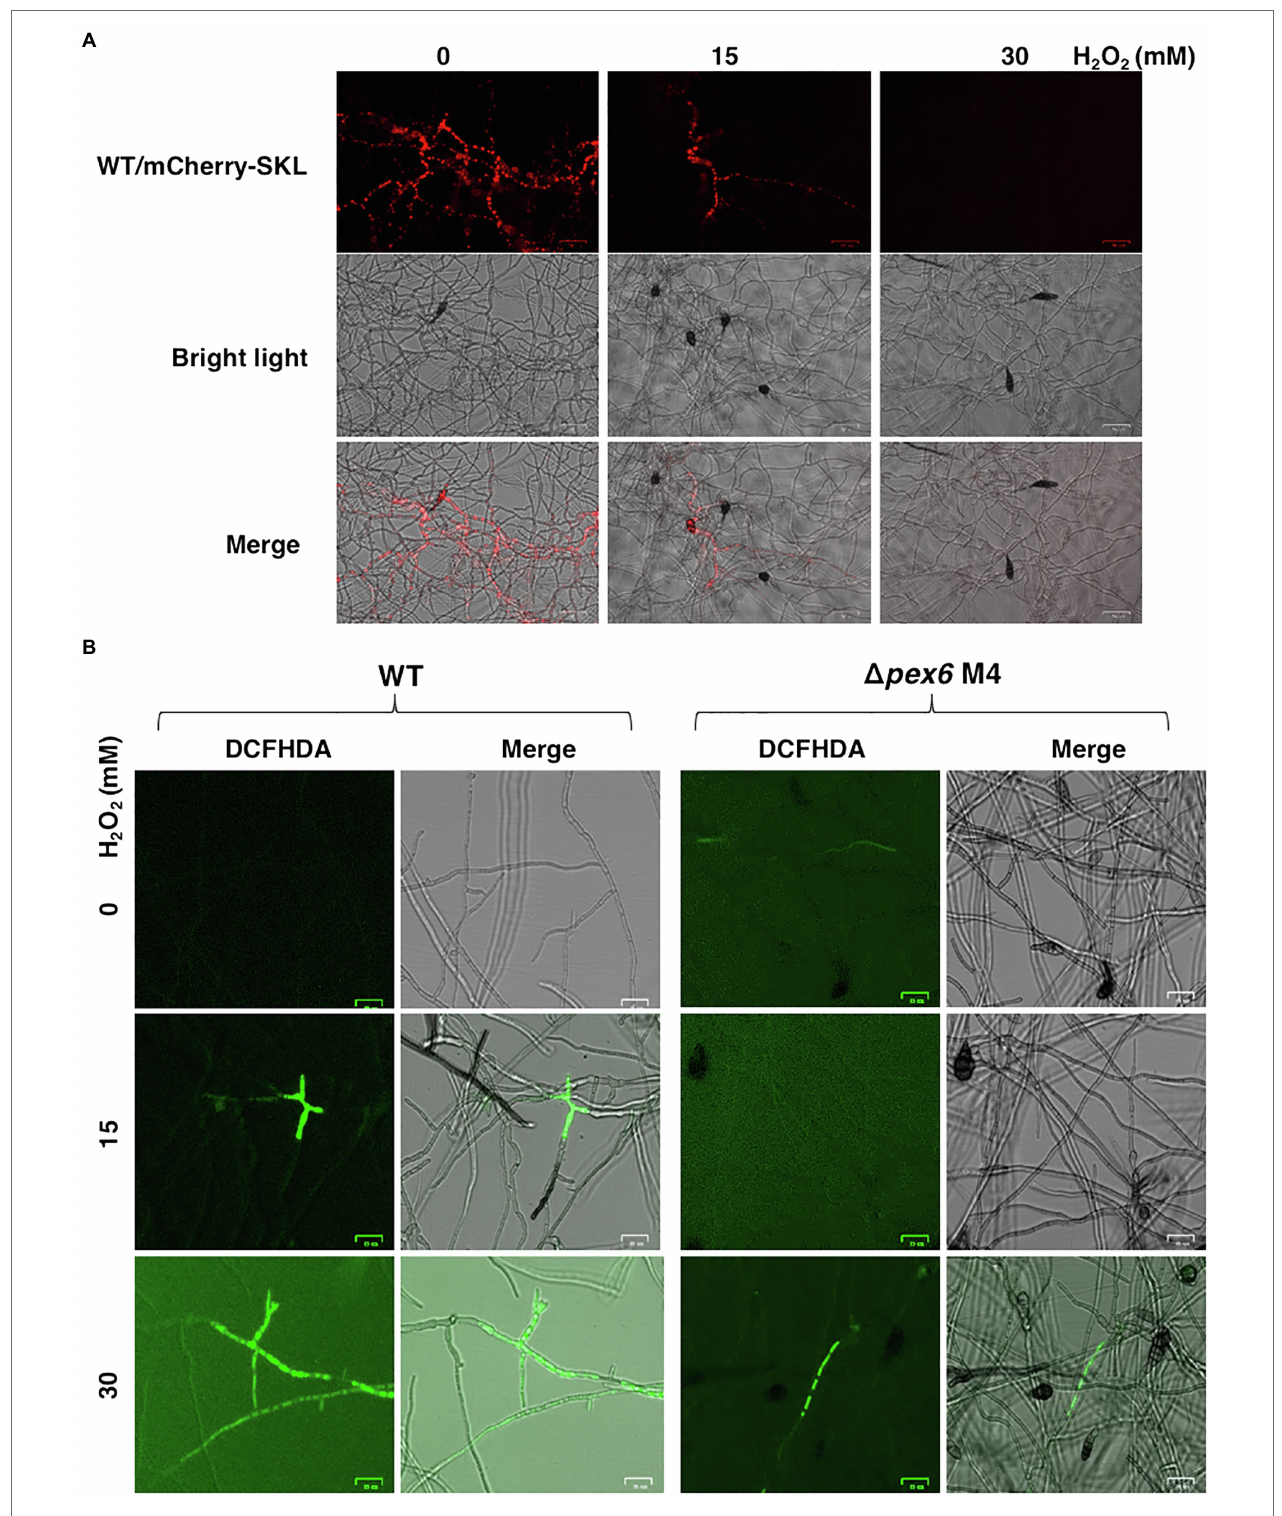
FIGURE 9 | Hydrogen peroxide (H 2 O 2 ) impacts the dynamics of peroxisomes, and Pex6 is required for H 2 O 2 import in A. alternata . (A) Hyphae of wild-type (WT) expressing a mCherry fluorescent protein tagging with a conserved tripeptides SKL at the carboxyl terminus in response to different concentrations of H 2 O 2 . WT was cultured in potato dextrose broth (PDB) with or without H 2 O 2 for 4 h and examined by a fluorescent microscope. (B) Hyphae of WT and ∆ pex6 -M4 grown in PDB with or without H 2 O 2 for 2 h were stained with 2 ' -7 ' -dichlorofluorescin diacetate (DCFHDA), displaying green fluorescence, indicative cellular accumulation of H 2 O 2